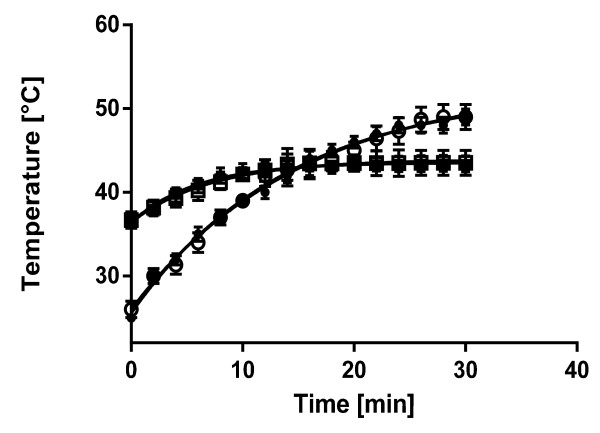
Heating behavior of uncoated and lipid-coated SPIONs within an alternating magnetic field. Uncoated (open symbols) and lipid-coated (closed symbols) Fe3O4 nanoparticles suspended at 0.02 mg/mL in citrate buffer, pH 7.4, were exposed in the MGS-1000 to an alternating magnetic field of 7.0 mT at 1.0 MHz (circles) and in the MHS to 16.6 mT at 13.6 MHz (squares). Temperature of suspension vehicle was recorded using an optical fiber probe. Data are shown as mean ± SD (n = 3).